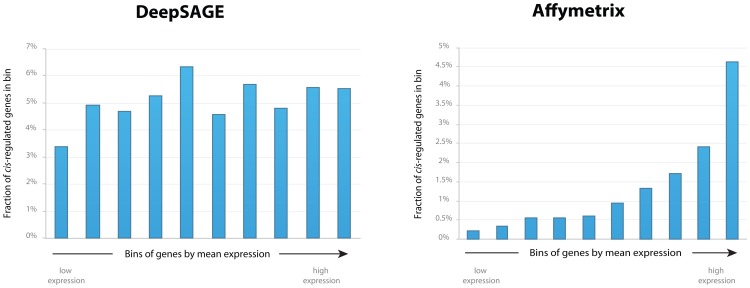
Fraction of cis-regulated genes in bins by mean gene expression levels for DeepSAGE and Affymetrix data.For each dataset, all genes were sorted by their mean gene expression levels, and divided into ten equal bins. The X-axis reflects these bins, which are sorted by increasing mean gene expression levels. The Y-axis reflects the fraction of cis-regulated genes that fall into each bin.